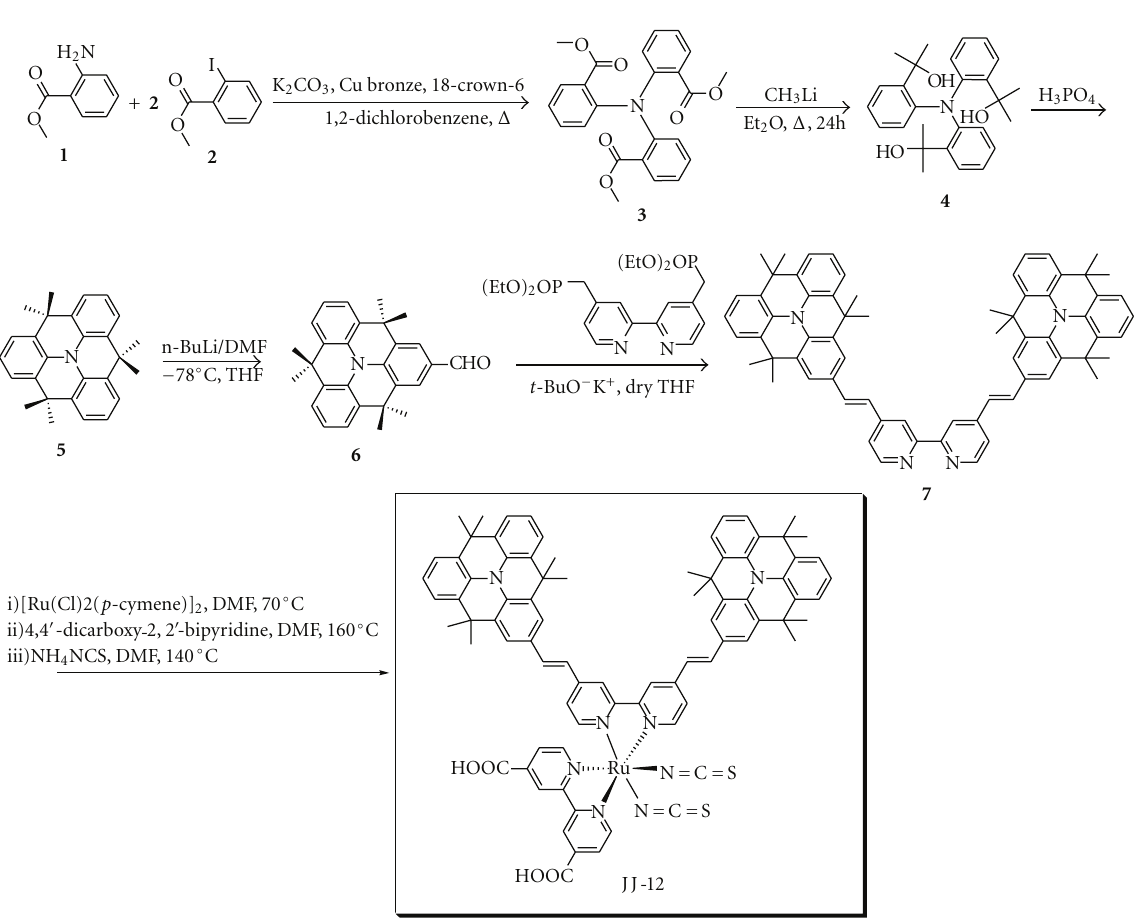
Scheme 1: Schematic diagram for the synthesis of sensitizers JJ-12